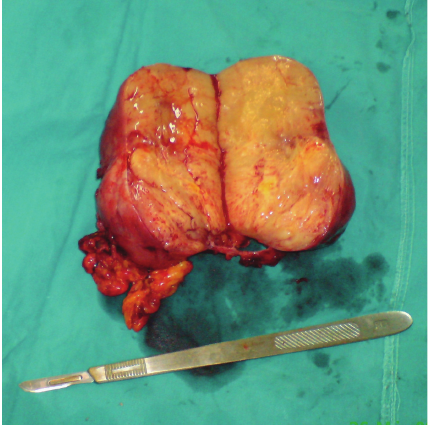
Figure 2: Gross appearance of the resected tumor, greatest diameter 13.5 cm.